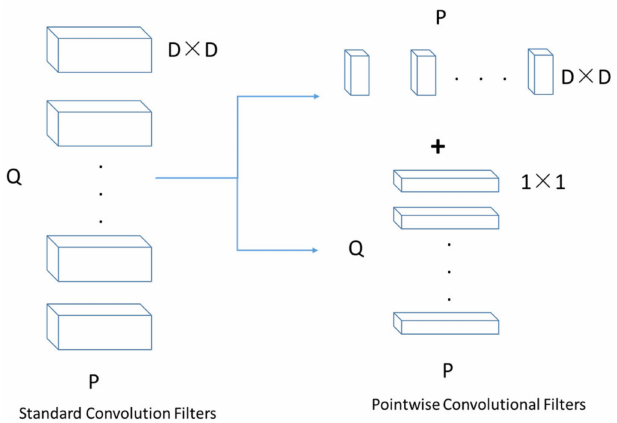
Figure 4. The principle of MobileNets.